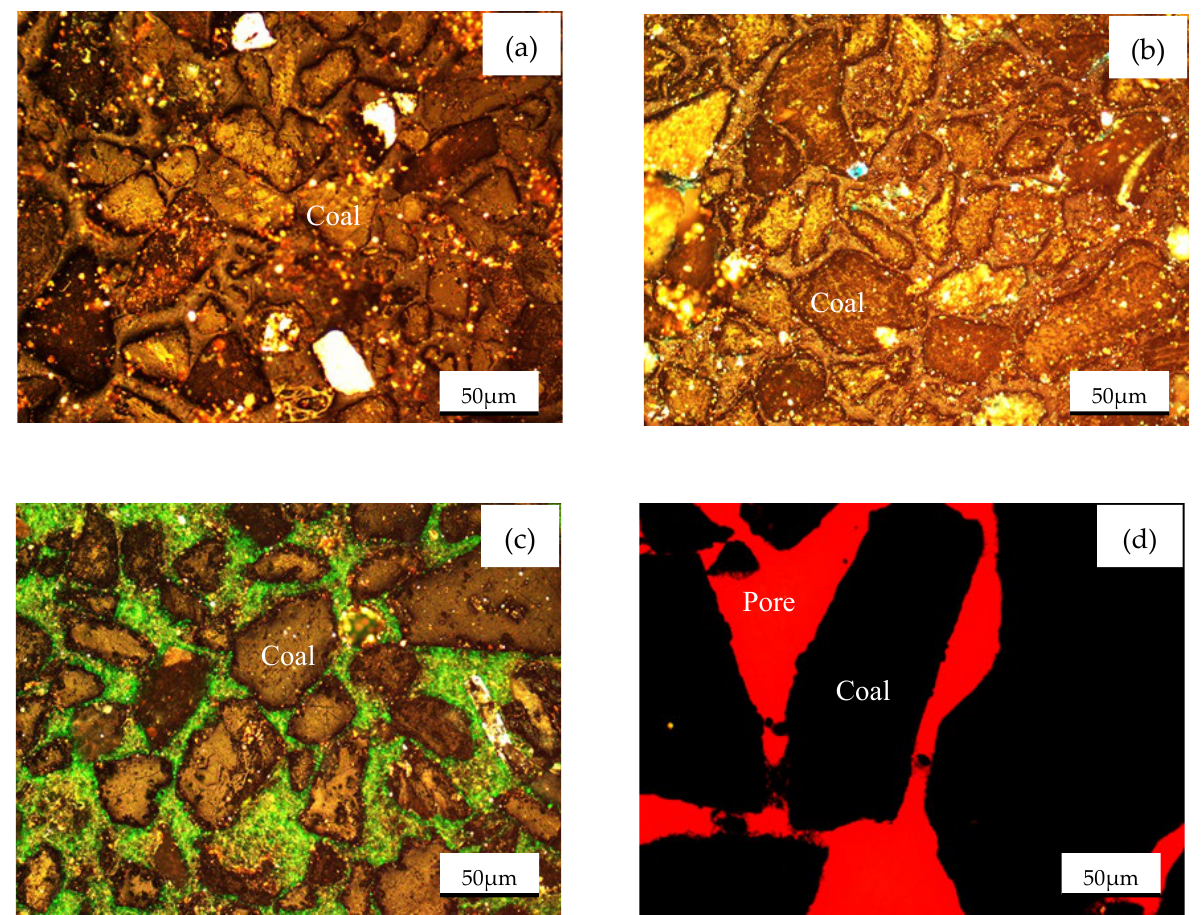
Figure 5. Pore images of filter cake solidified by epoxy resin and color paste. ( a ) Epoxy resin and black colorant; ( b ) epoxy resin and blue colorant t; ( c ) epoxy resin and yellow colorant; ( d ) epoxy resin and red colorant.